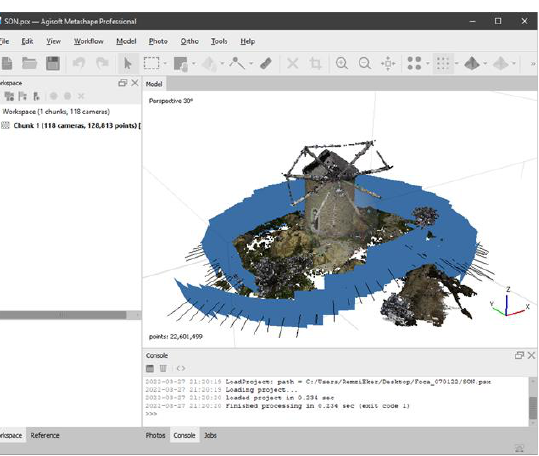
Figure 3. The GUI of Emlid Studio 1 Beta 10.